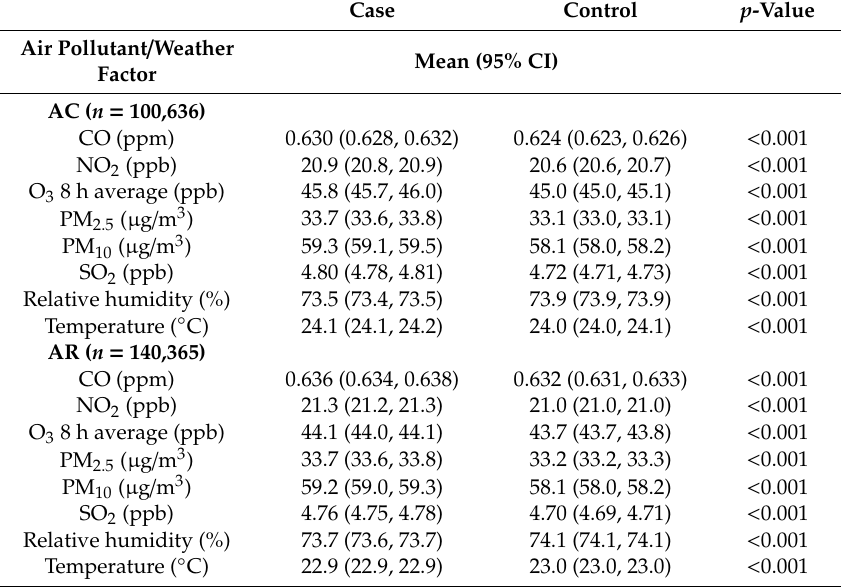
Table 2. Mean concentrations of air pollutants and meteorological data by case and control periods between 2004 and 2013.